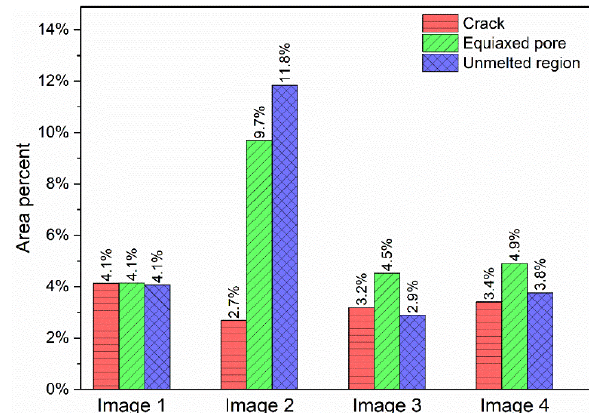
Figure 5. Area percentages of different classes of microstructures in the four SEM images.